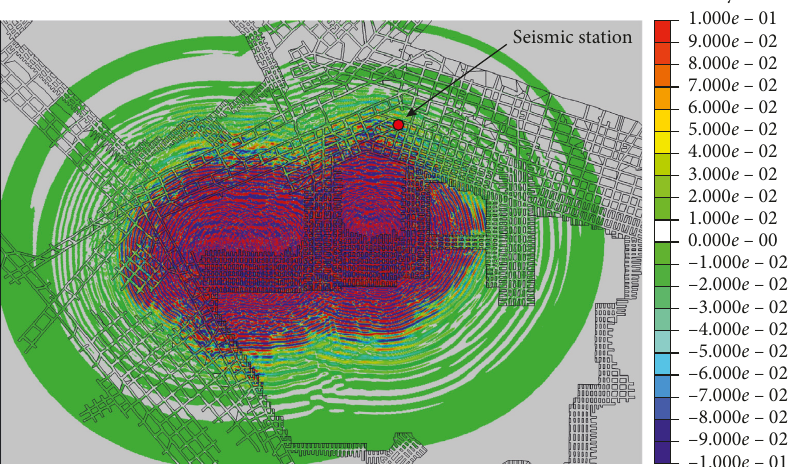
Figure 10: Vertical velocity propagation wave (mm/s) after 0.2sec within the dolomite I layer.